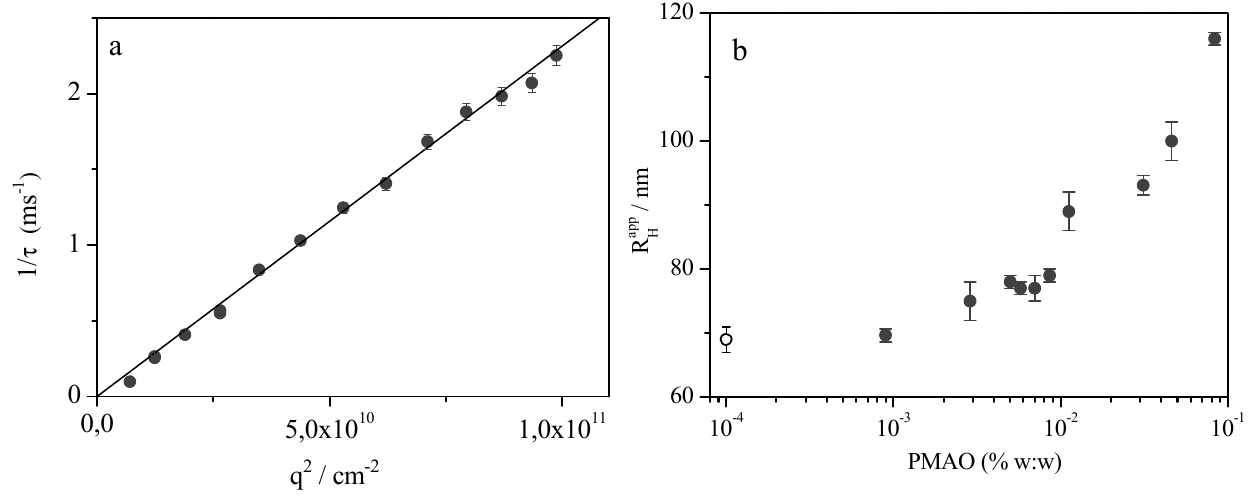
Figure 2. ( a ) The inverse decay time values vs. the square wavevector for mixtures of Aerosol OT 0.03 M with PMAO 0.0824% w:w. ( b ) Variation of the apparent hydrodynamic radius of vesicles with PMAO concentration. The open circle represented on the PMAO concentration of 10 − 4 % corresponds to the hydrodynamic radius of Aerosol OT vesicles. The Aerosol OT concentration was kept constant at 0.03 M.